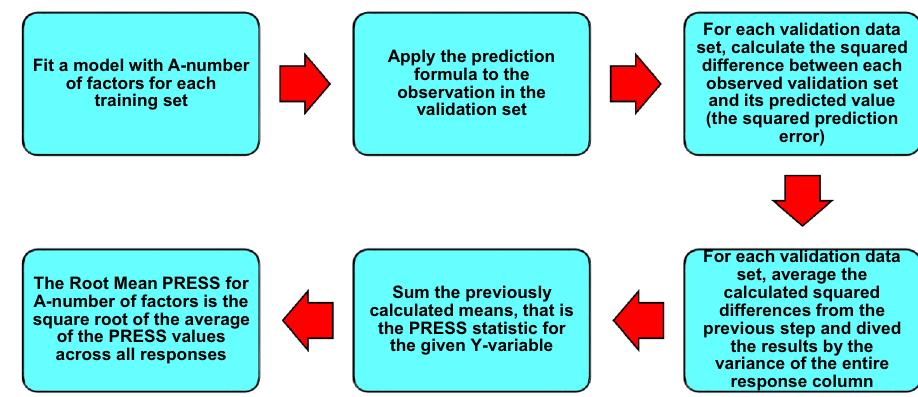
Fig. 3 Process of finding